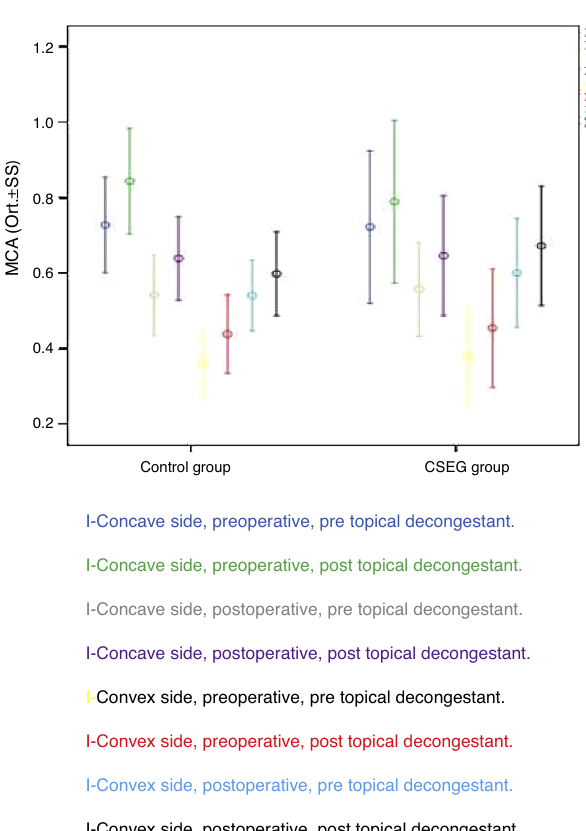
Figure 5 Average minimal cross-section area (MCA1) values of the study and control group.